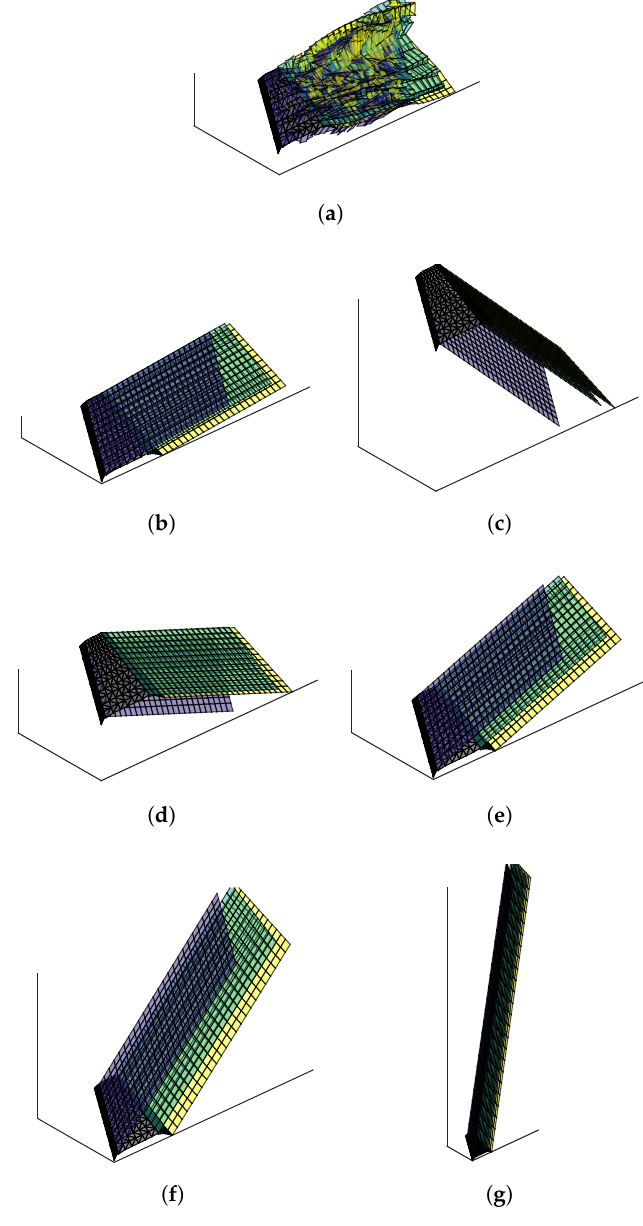
Figure 13. Wake shapes analysed on the NASA Trap Wing LaRC Configuration 1 at an angle of attack of five degrees [5]. ( a ) Relaxed (force-free); ( b ) freestream fixed (drag-free, angle of attack +5 degrees); ( c ) prescribed to − 45 degrees; ( d ) prescribed to − 20 degrees; ( e ) prescribed to +20 degrees; ( f ) prescribed to +45 degrees; ( g ) prescribed to +80